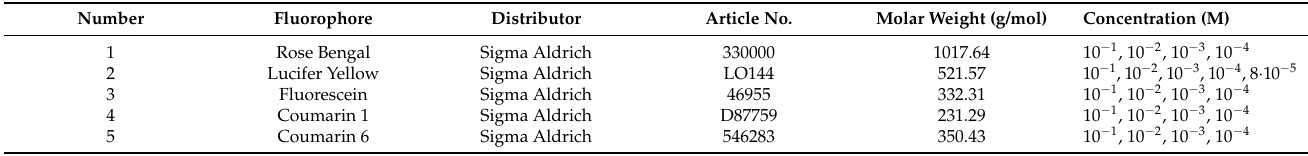
Table 8. Sample fluorophores with the respective